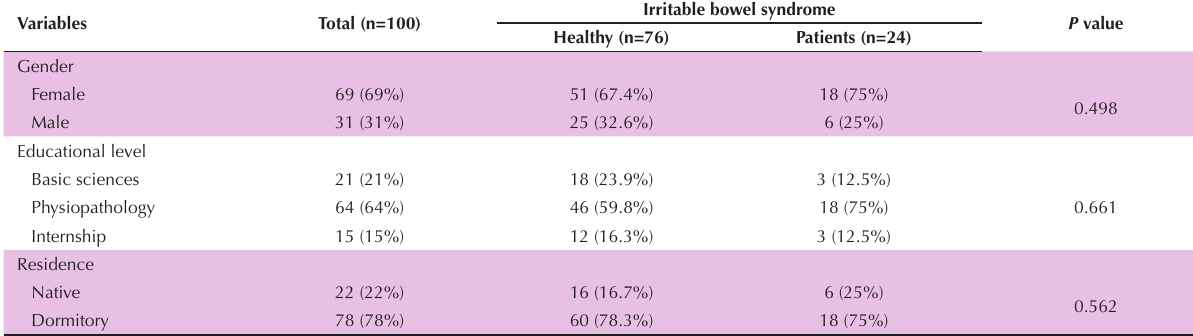
Irritable bowel